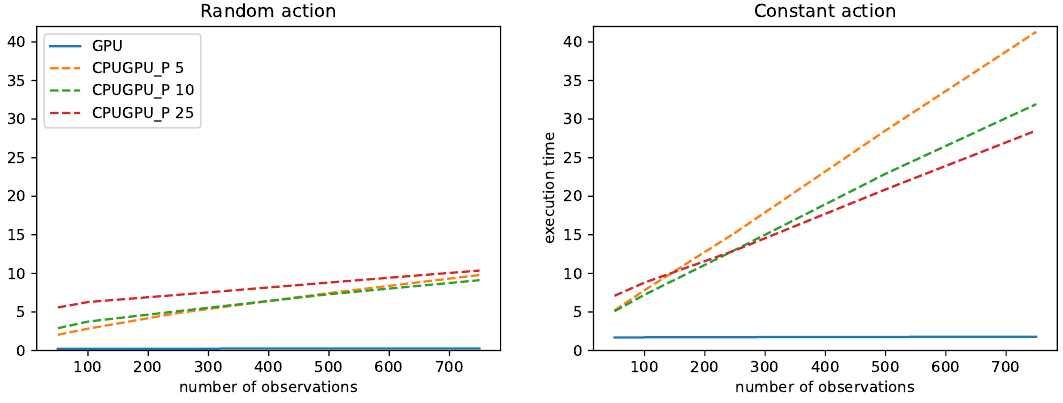
Figure 5. Comparison of execution time of the two best performing implementations with respect to the number of observations. Results for both scenarios without DNN.